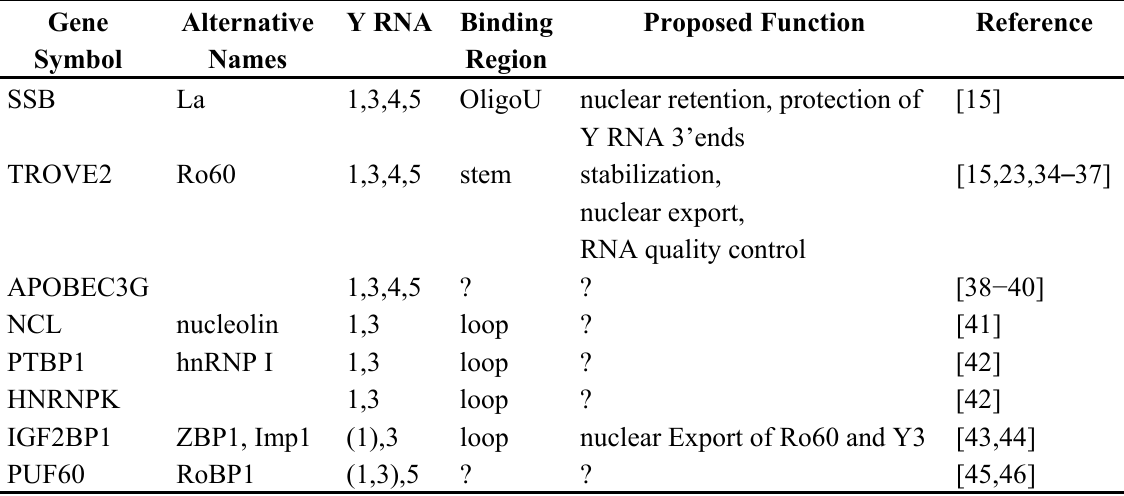
Table 1. Y RNA binding